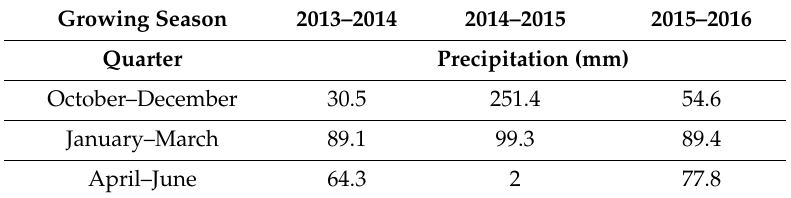
Table 4. Doukkala irrigation scheme: Quarterly precipitation (P) of wet, dry and reference years. Growing